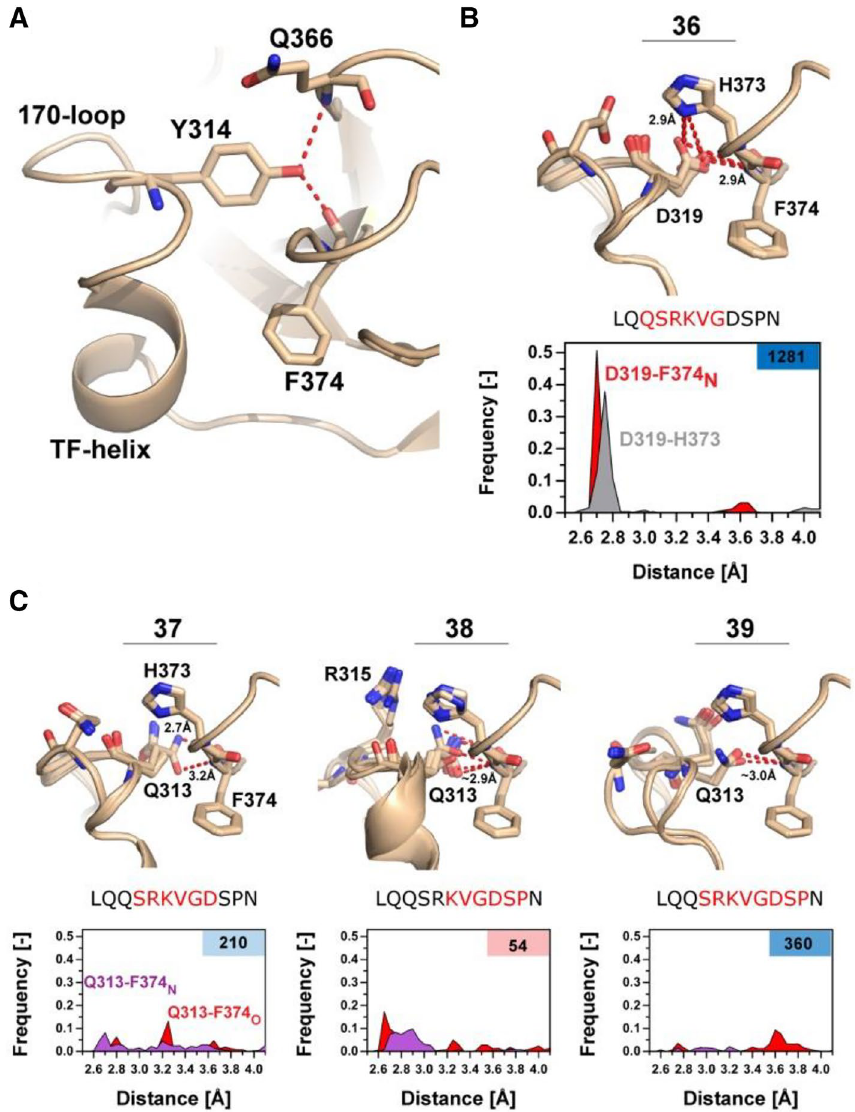
Figure 6. Shorter Loop Lengths Allow for Trypsin-like Interactions with the Protease Domain. ( A ) Overview of trypsin-like interaction in a FVIIa-trypsin variant (PDB ID: 4z6a), with Y314 (172c) inserting into the protease domain, stabilizing Q366{c217} and F374{c225} by polar contacts (red) as observed in wild-type trypsin. ( B ) 10 models with lowest RMSD/REU of the most active variant (no 36.) from group 2, reconstructed using the NGK protocol. D319{c170G} makes polar contacts (red) with the backbone nitrogen of F374{c225} and sidechain of H373{c224} to stabilize the S1-pocket. A frequency histogram of the polar contacts between D319{c170G}-H373{c224} (grey) or D319-F374 N (red) highlights the favourability of the interaction (n = 250) with S-2288 activity relative to FVIIa in the right top-corner and deleted amino acids are coloured in red on the shown sequence. ( C ) Overview of variants 37–39 with 3 groups of 5 modelled structures selected from RMSD groupings showing the lowest REU (see supplemental Fig. S6). Average hydrogen-bond distance is shown in red when the distance is < 3.5 Å. Frequency histograms (n = 250) of the polar contacts between Q313{c170A} -F374 N {c225} (red) or Q313{c170A}-F374 O {c225}